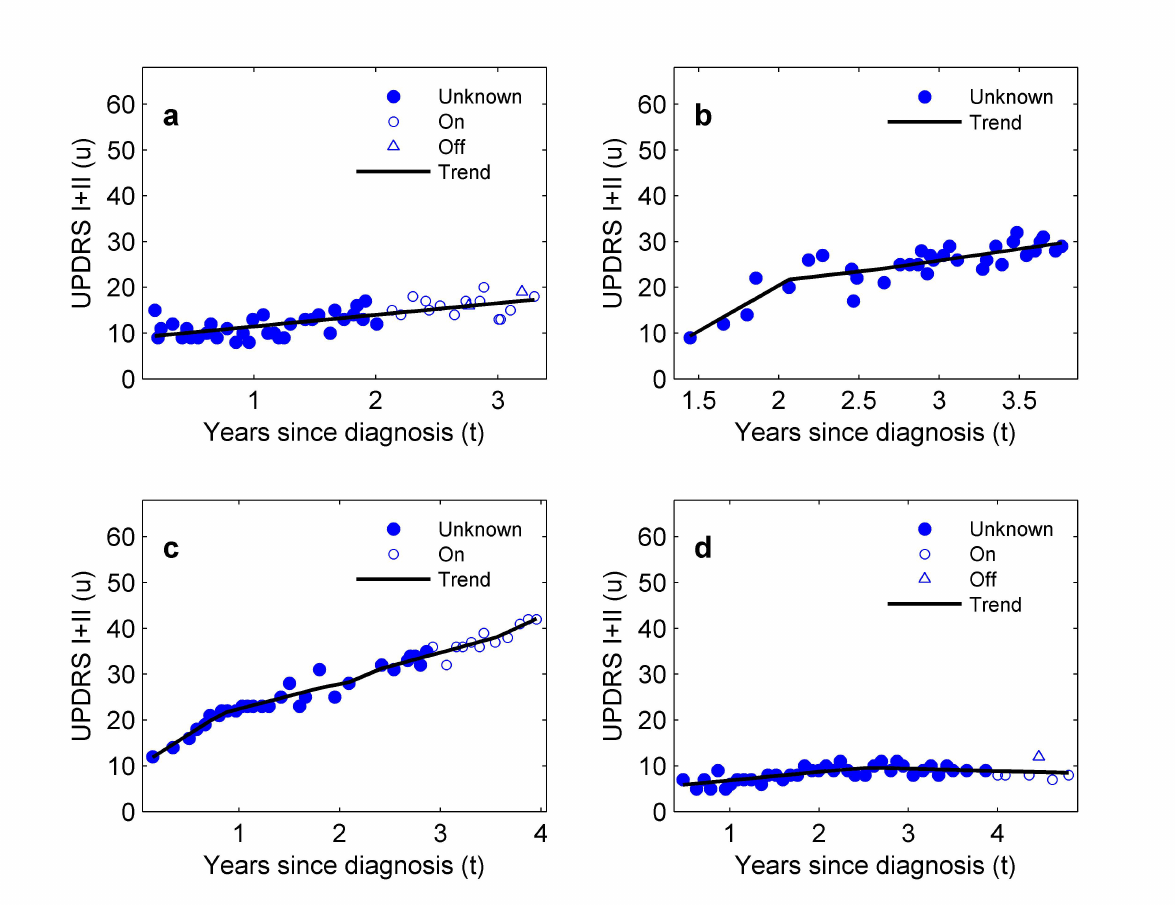
Figure 3. Four examples of patients in the PatientsLikeMe (PLM) dataset whose self-reported symptom dynamics conform to the current consensus picture of slow, predictable Parkinson’s disease symptom progression. Increase is generally smooth, variation around the trend (residuals) are generally small. “Unknown” refers to data in which the patient did not state whether they were on treatment (on) or off treatment (off) at the time of the symptom